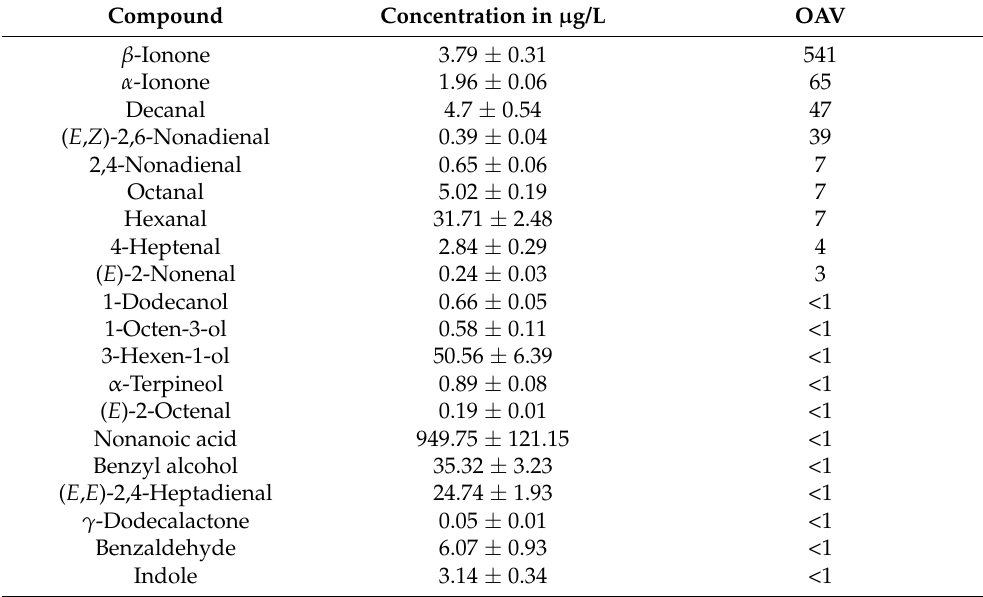
Table A11. Results of semi-quantification and calculated OAVs for sample